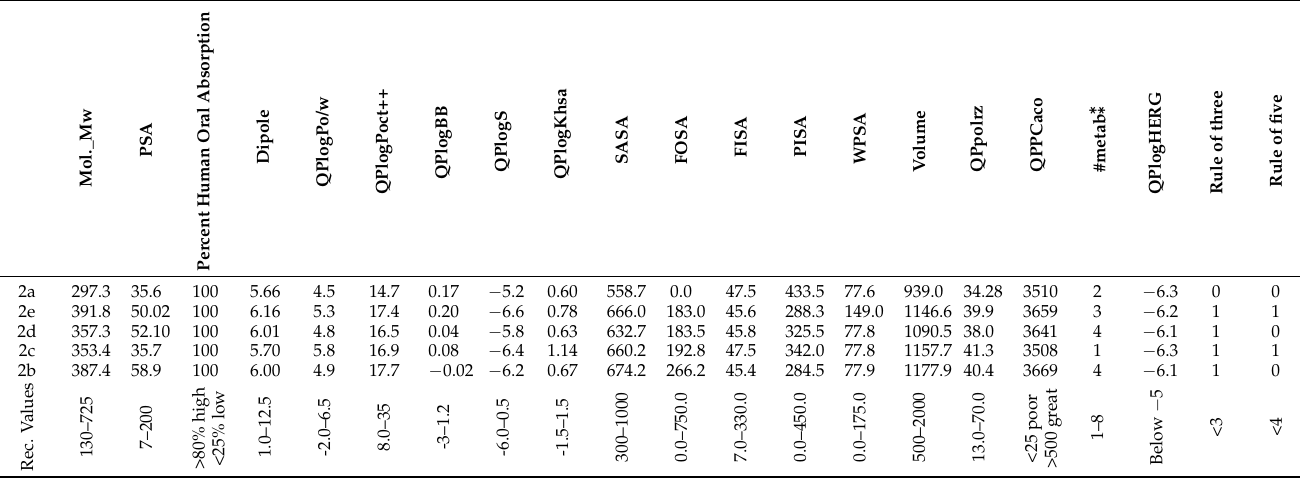
Table 3. The ADME-T analysis.